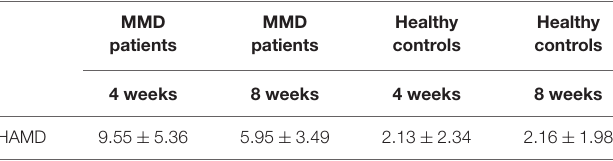
TABLE 4 | Descriptive of Hamilton depression rating scale (HAMD) score for mild-to-moderate depression (MMD) patients and healthy controls during follow-up (mean ± SD).